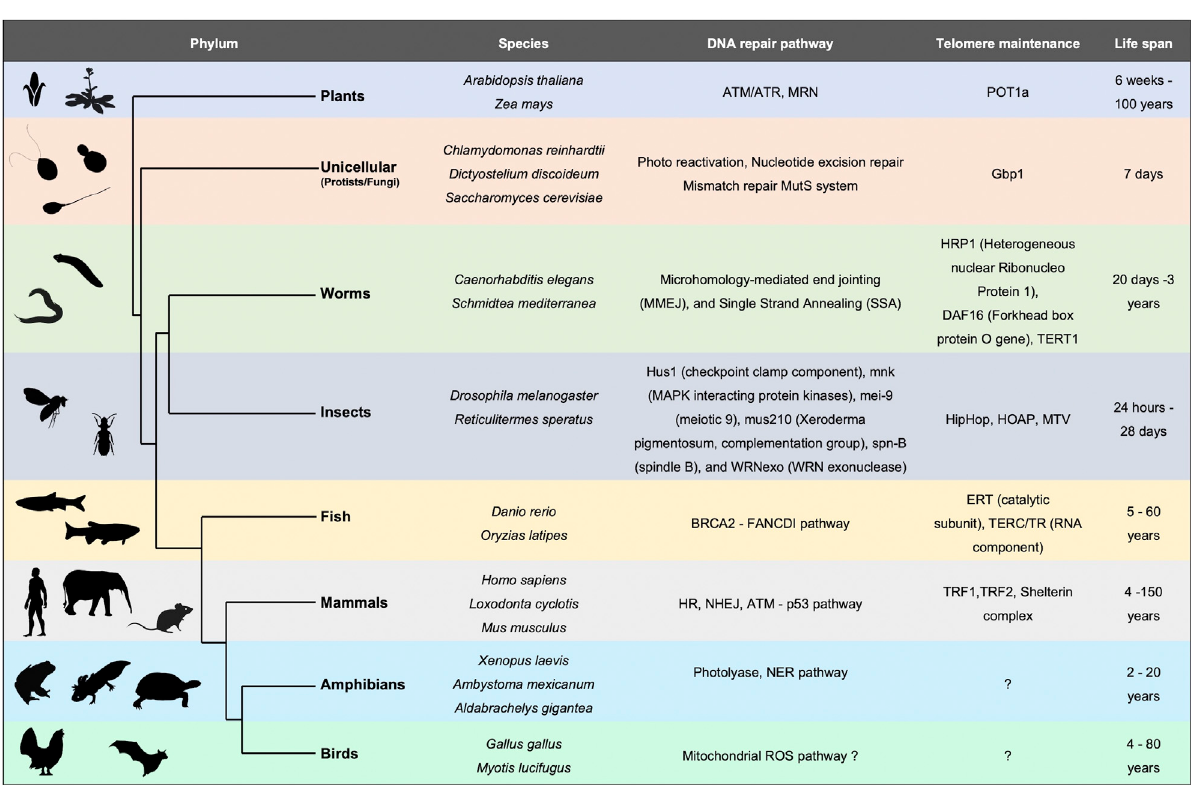
FIGURE 1 Evolutionary perspective of DNA repair mechanisms and telomere maintenance as primary determinants of lifespan. Table depicting different organisms across the phylogenetic tree with varied lifespans. Summary of DNA repair pathways and telomere associated proteins which positively affect the